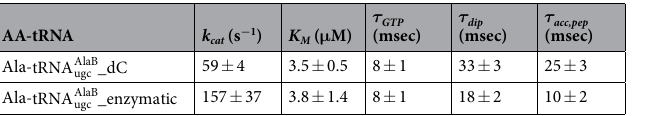
Table 1. Kinetic parameters for fMA dipeptide formation (see Fig. 3). Mean values were calculated from at least two independent experimental results with their propagated standard deviations.